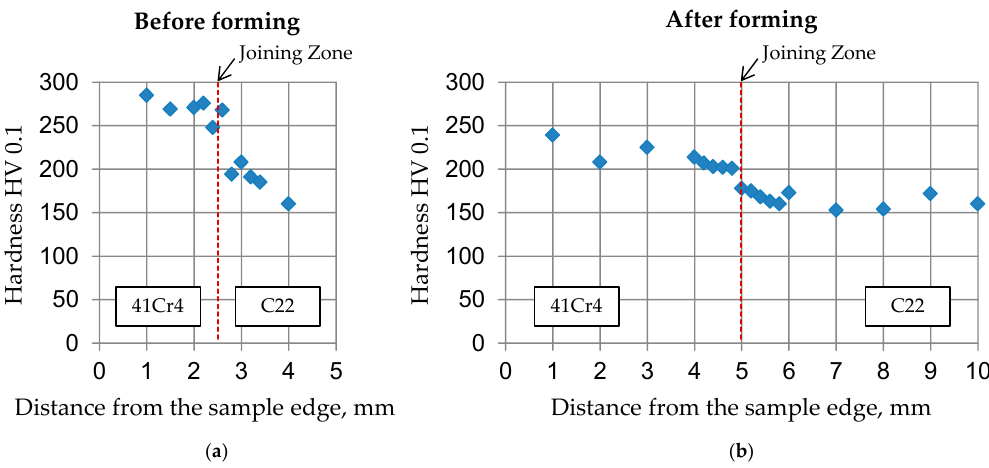
Figure 7. Hardness profiles HV 0.1 in a deposition-welded workpiece ( a ) and in a forged bevel gear ( b ).